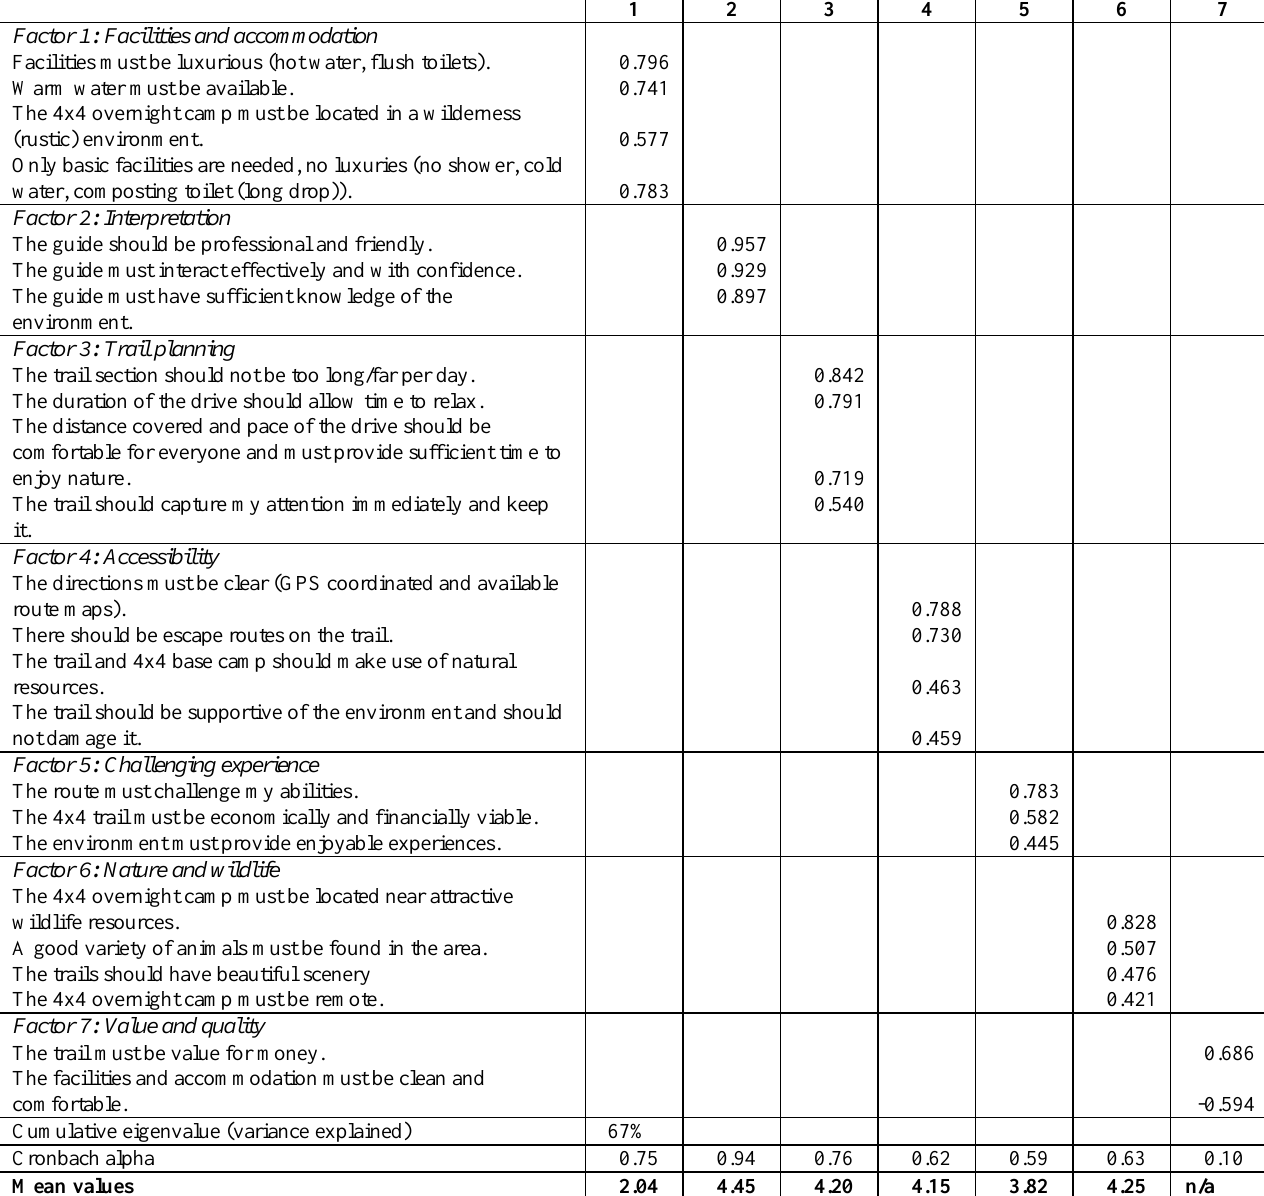
Table 4: CSFs for a memorable 4x4 ecotrail